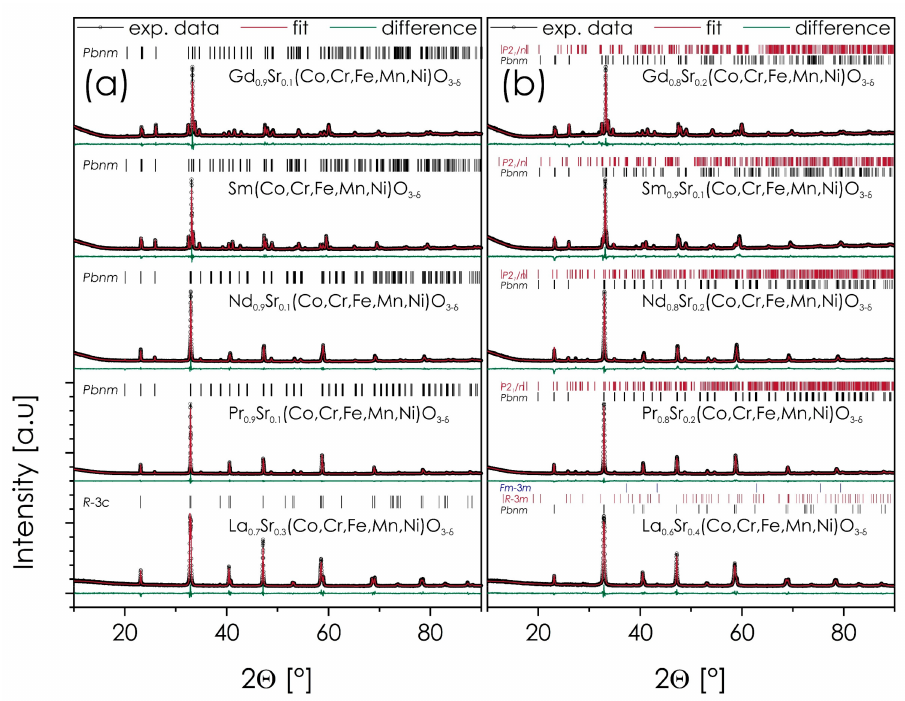
Figure 6. XRD diffractograms of the selected Ln 1 − x Sr x (Co,Cr,Fe,Mn,Ni)O 3 − δ (Ln = La, Pr, Gd, Nd, Sm) pellets, sintered at 1000 ◦ C for 20 h and quenched to RT: ( a ) data for compositions just below Sr solubility limit; ( b ) compositions with Sr content higher than the solubility